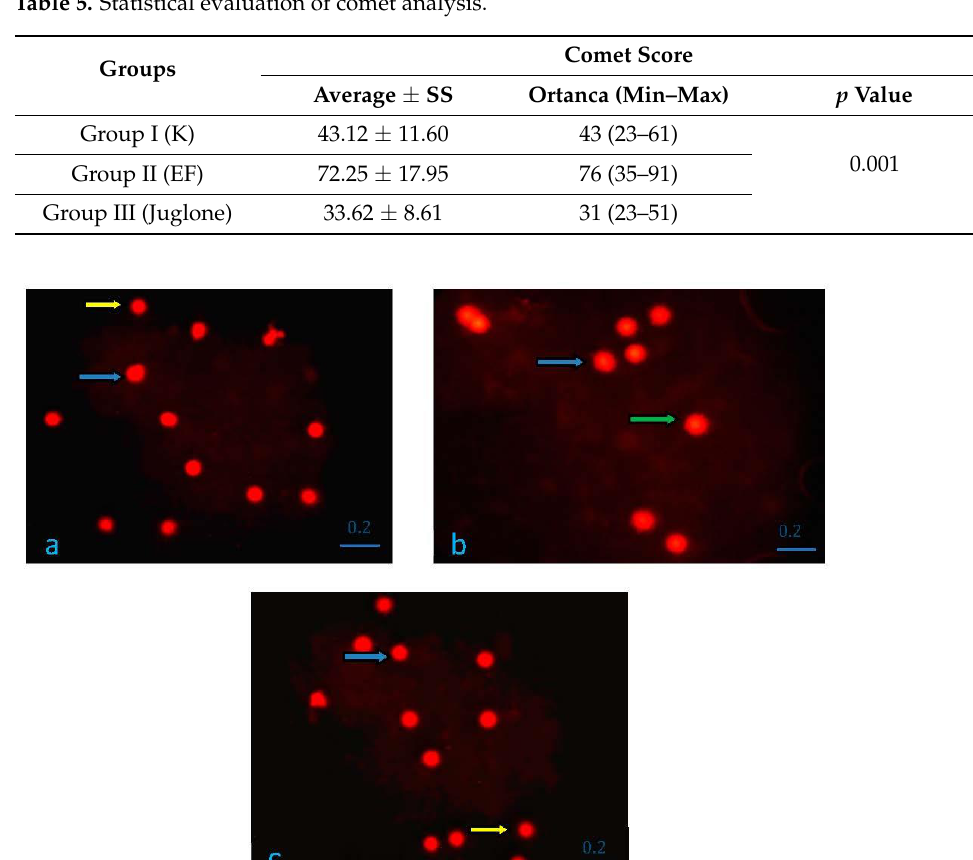
Table 5. Statistical evaluation of comet analysis.